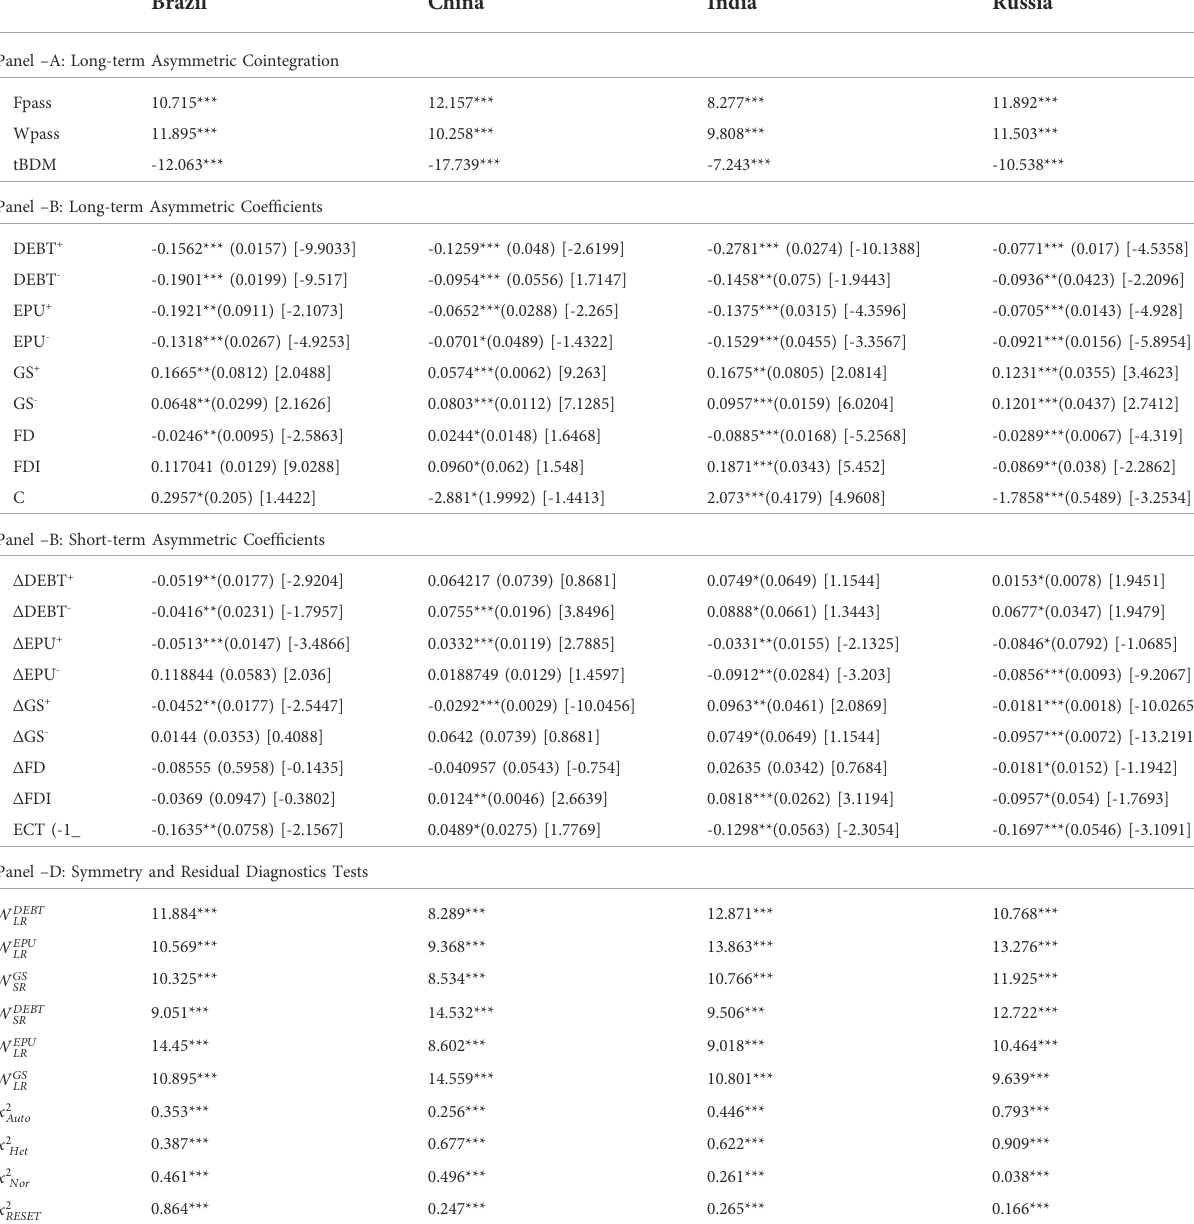
TABLE 7 Results of the asymmetric nexus between debt, EPU, GS, and institutional quality in